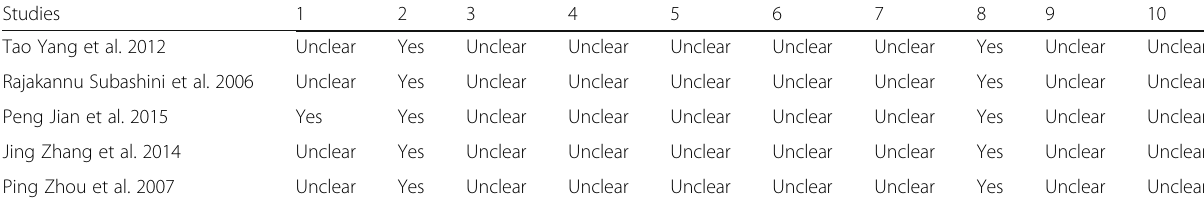
Table 7 Assessment of the risk of bias for animal studies